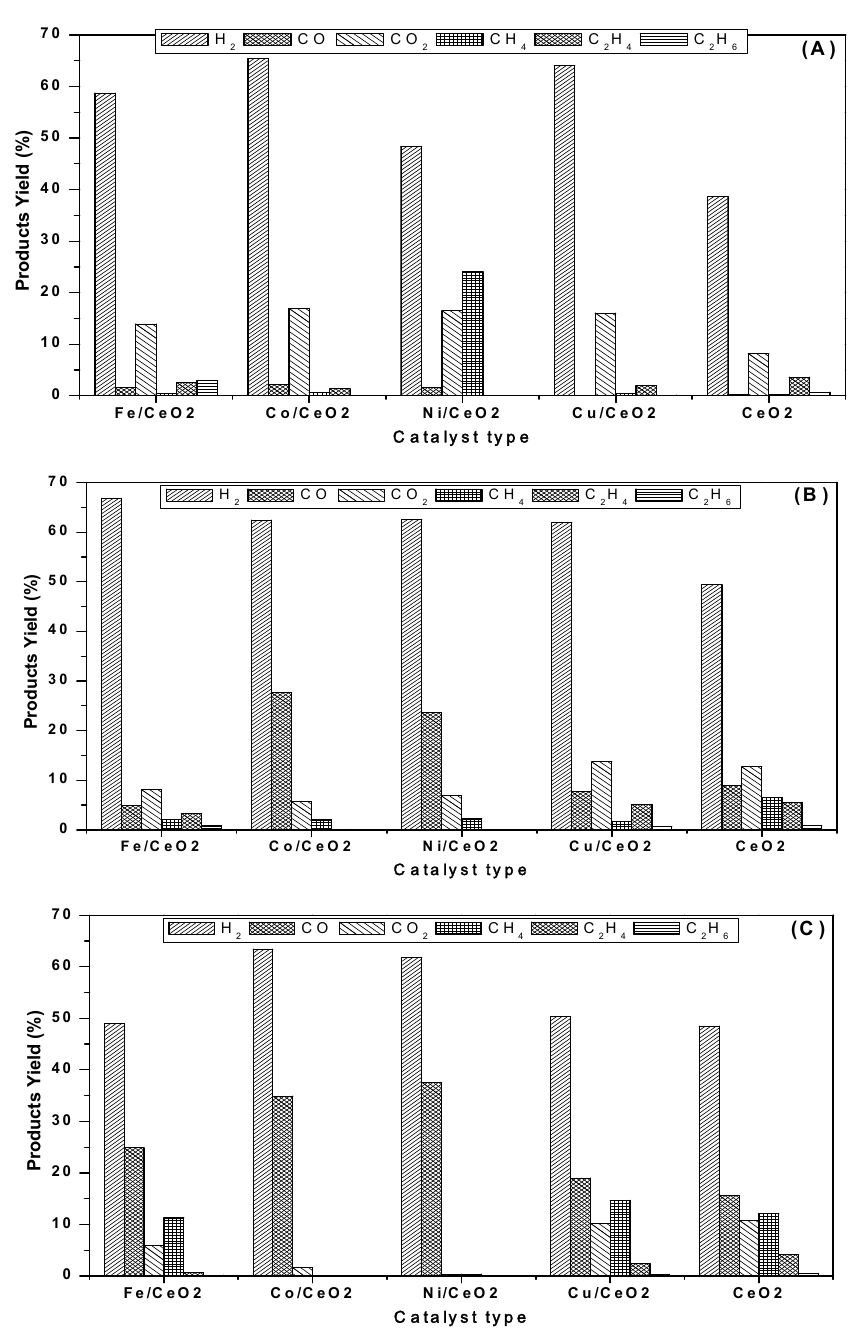
Figure 7. Effect of metal type on major product yield at 400 °C ( A ); 600 °C ( B ) and 800 °C ( C ). Reaction conditions: S/C = 3, m cat =250 mg, F T = 150 cm 3 /min. conditions: S/C = 3, m cat =250 mg, F T = 150 cm 3